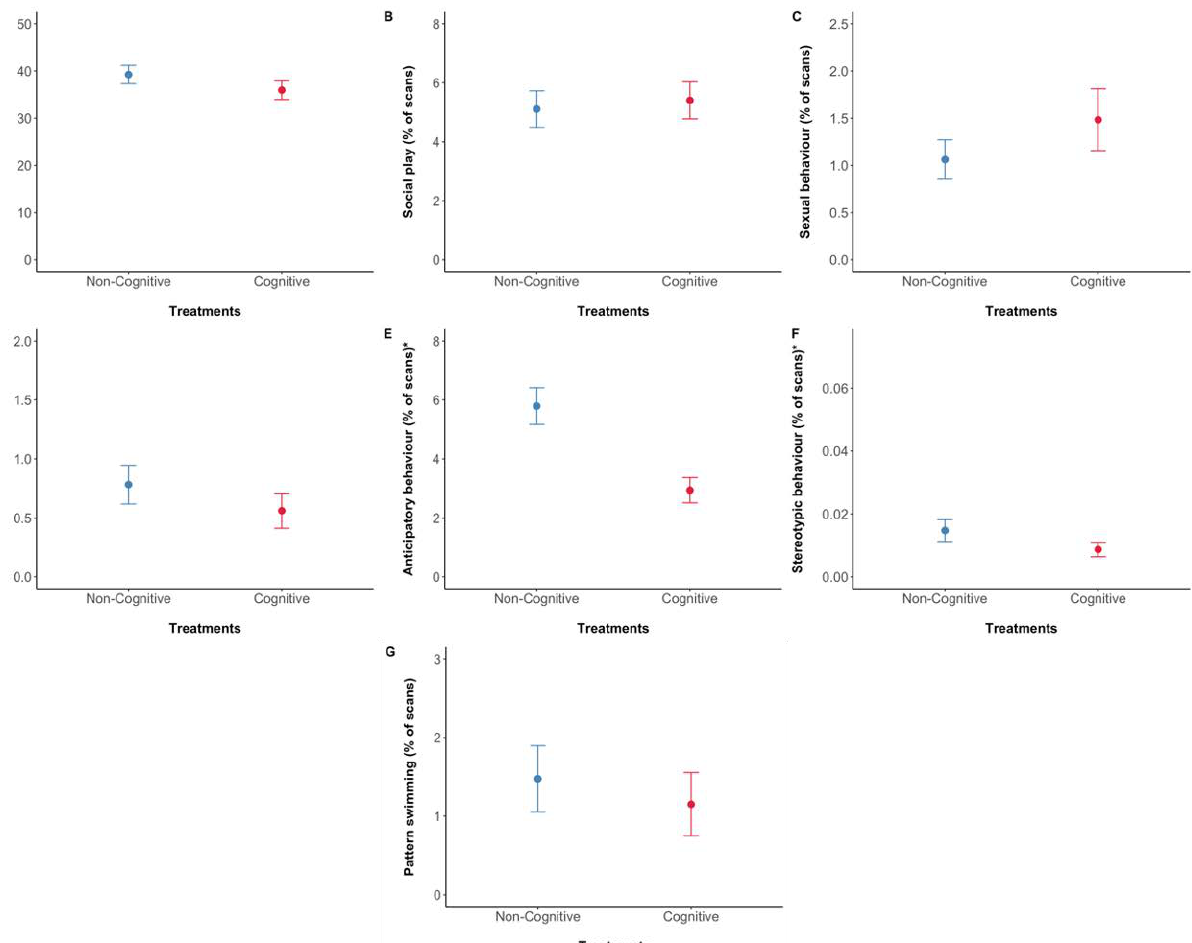
Figure 7. Percentage of behaviours displayed by the dolphins between cognitive and non-cognitive treatments. ( A ) Synchronous swimming; ( B ) social play; ( C ) sexual behaviour; ( D ) agonistic be- haviour; ( E ) anticipatory behaviour; ( F ) stereotypic behaviour; ( G ) pattern swimming. Percentage of scans y -axis labels describe the percentage of scans where the behaviour was performed out of the total visible scans in the focal 5 min observation. Means are represented by filled dots accompanied by standard error bars. Asterisks (*) by plot names indicate which behavioural frequencies were significantly different between